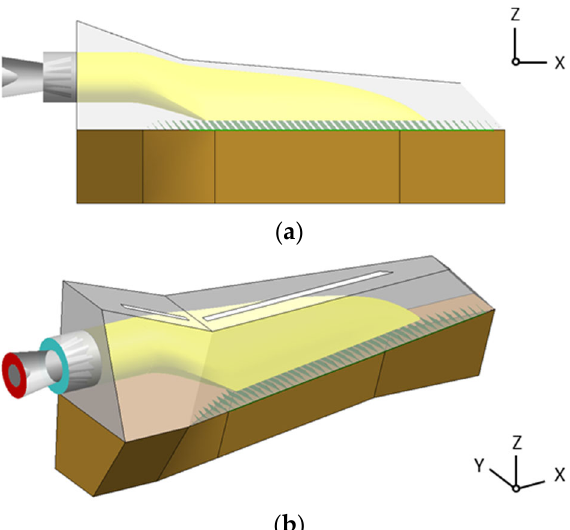
Figure 20. Installation position of the de fl ectors. ( a ) Left view; and ( b ) free view.